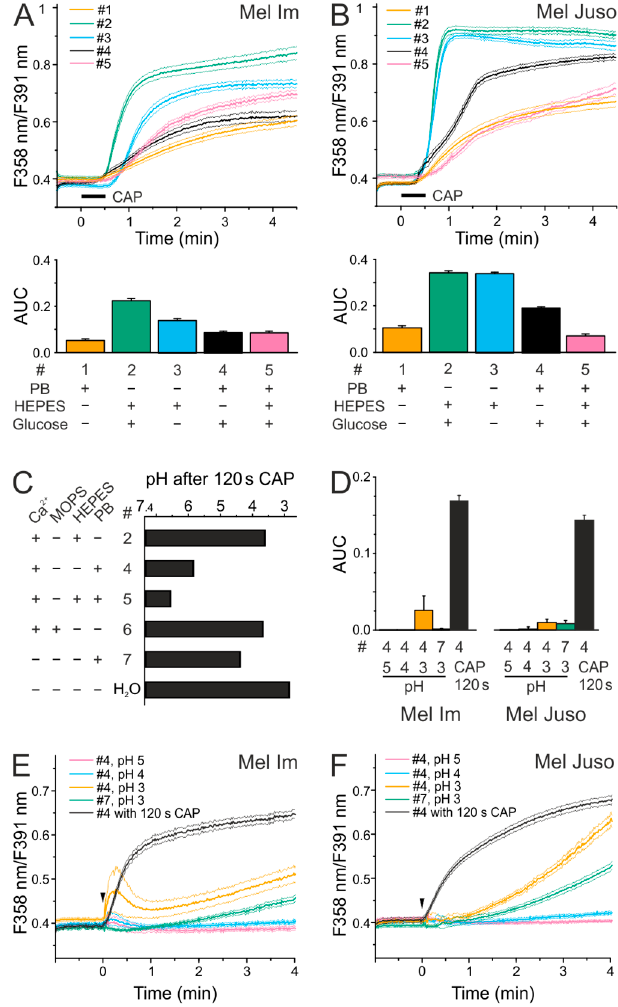
Figure 1. The intensity of cold atmospheric plasma (CAP)-induced Ca 2 + influx depends on the composition of the solutions and CAP causes an acidification. ( A , B ) Analysis of the e ff ect of di ff erent solutions on 30 s CAP-induced changes in cytoplasmic Ca 2 + level of melanoma cells. ( A ) Mel Im ( n = 137–660) and ( B ) Mel Juso ( n = 86–500) cells were washed in the Ca 2 + -containing solutions 1, 2, 3, 4, or 5 (#4 data identical to Figure 1 in [26]). After the removal of the respective solutions, cells were treated with 30 s CAP. Traces represent mean and the 99% confidence interval (CI) of the mean. ( C ) The solutions #2, 4, 5, 6, 7 or bidestilled water (pH 7.4) were exposed to 120 s CAP as 7 × 20 µ L drops. Measurement of pH was performed in a 1.5 mL reaction vessel. Data are shown as mean. ( D – F ). Analysis of the e ff ect of an acidic pH on cytoplasmic Ca 2 + levels of Mel Im (( D , E ), n = 485–999) and Mel Juso (( D , F ), n = 275–376) cells. 100 µ L of pbECS (#4; pH 3,4,5) and pbECS − Ca 2 + (#7; pH 3) was added onto melanoma cells (indicated by an arrow). The application of 100 µ L of 120 s CAP-treated pbECS (#4) to Mel Im (( D , E ), n = 485) and Mel Juso (( D , F ), n = 321) cells served as control. Phosphate-bu ff ered (PB), area under the curve (AUC), fluorescence intensity